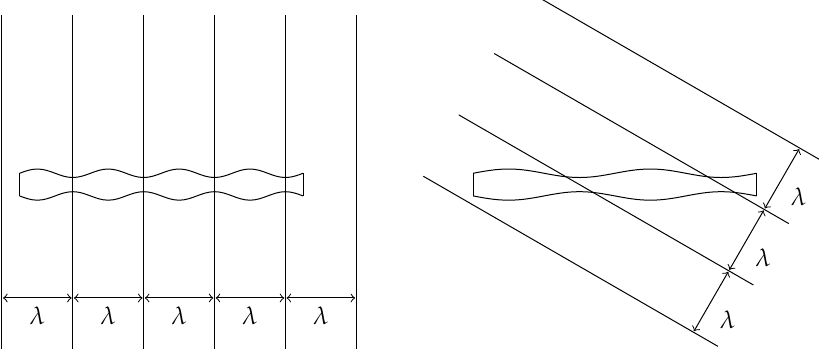
Figure 7. Dimensionless maximal absorption width as a function of the direction of the incoming waves. Each line corresponds to the absorption width for the combination of several modes. The dotted lines are the unconstrained absorption widths. The solid lines are the absorption widths under the constraint b = 1.0.